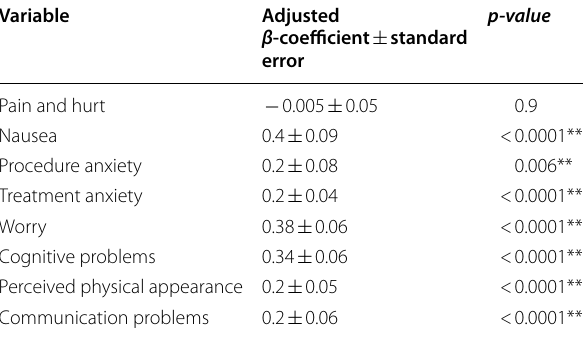
** Correlation is significant at the 0.01 level (2-tailed)